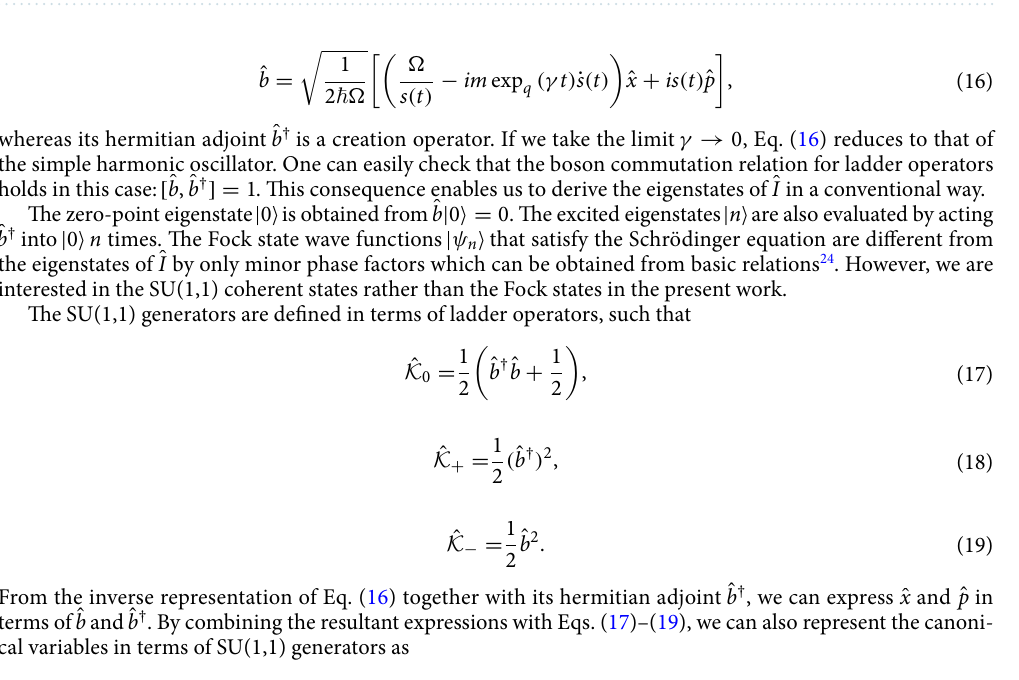
Figure 2. Time evolution of s 1 ( t ) ( A ) and s 2 ( t ) ( B ) for several different values of q . We used ω 0.1 s 0,1 s 0,2 = =